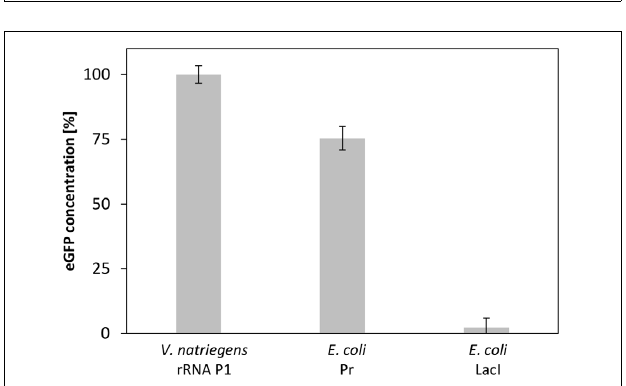
FIGURE 8 | CFPS of eGFP with V. natriegens extract using different promoter elements. The strong promoters rRNA P1 from V. natriegens and Pr from E. coli , and pLacI from E. coli as a weak promoter were used. Error bars represent standard deviations of triplicate